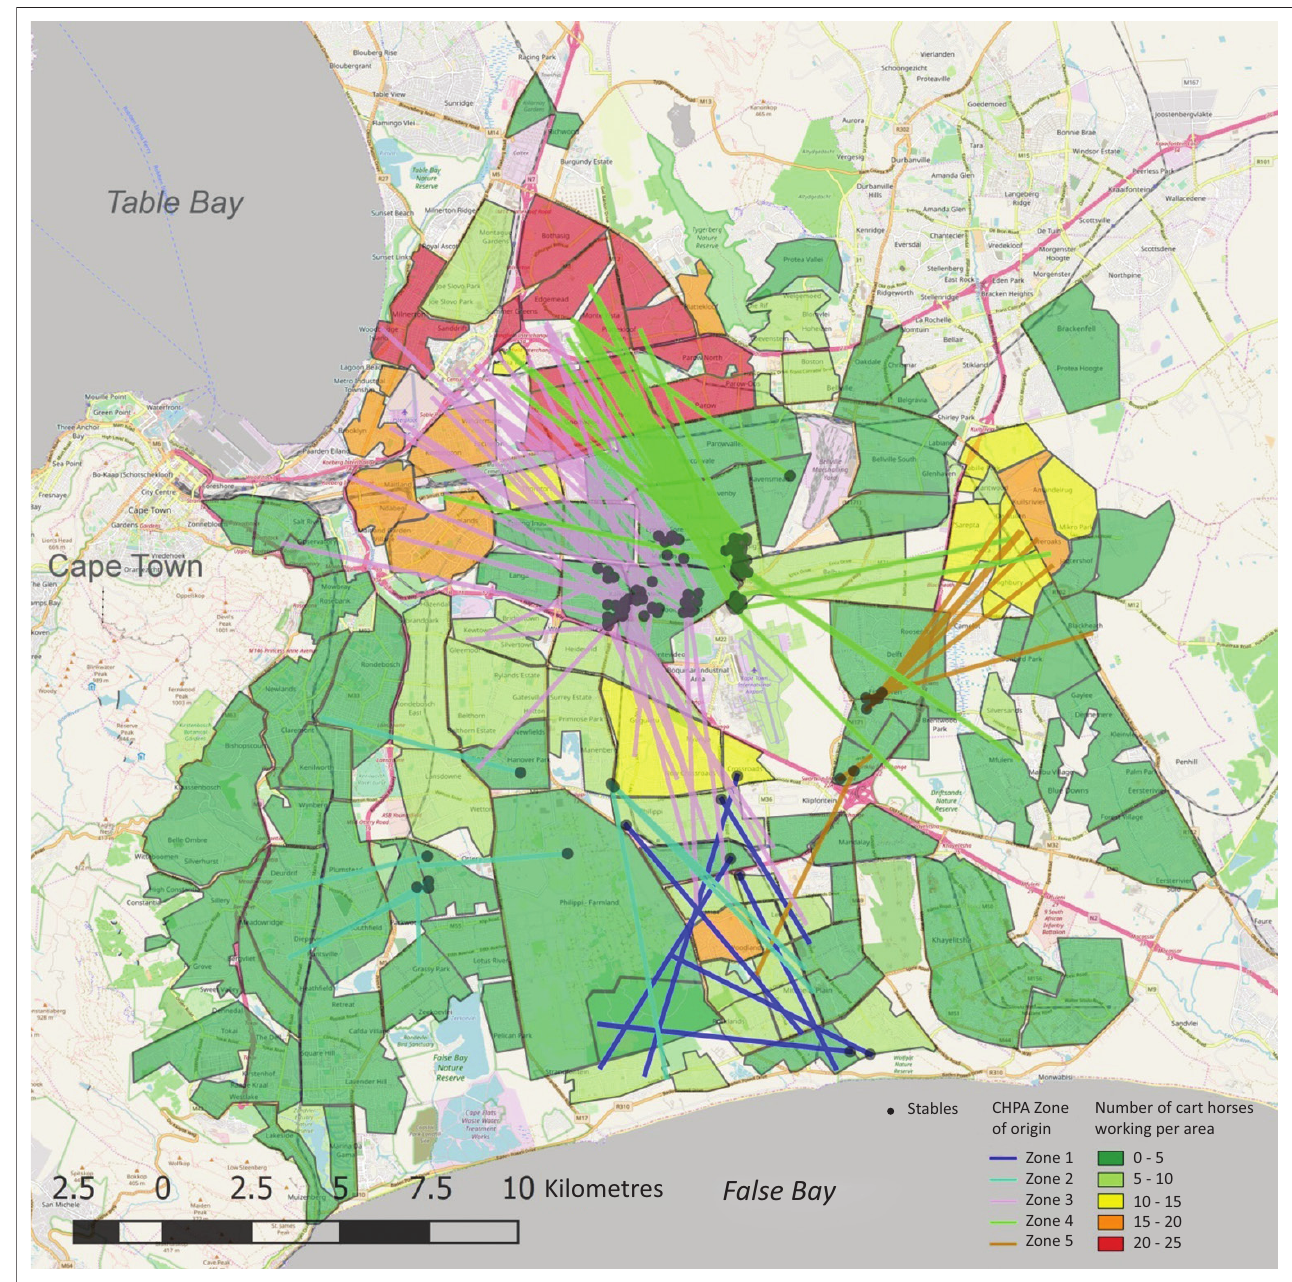
FIGURE 3: A map to represent the number of cart horses regularly working in each neighbourhood. Dots indicate stable locations. Areas are coloured on a green to red scale highlighting the number of horses working per area. Also, the median angle of direction and mean distance travelled from each stable point are demonstrated and colour coded for each of the five